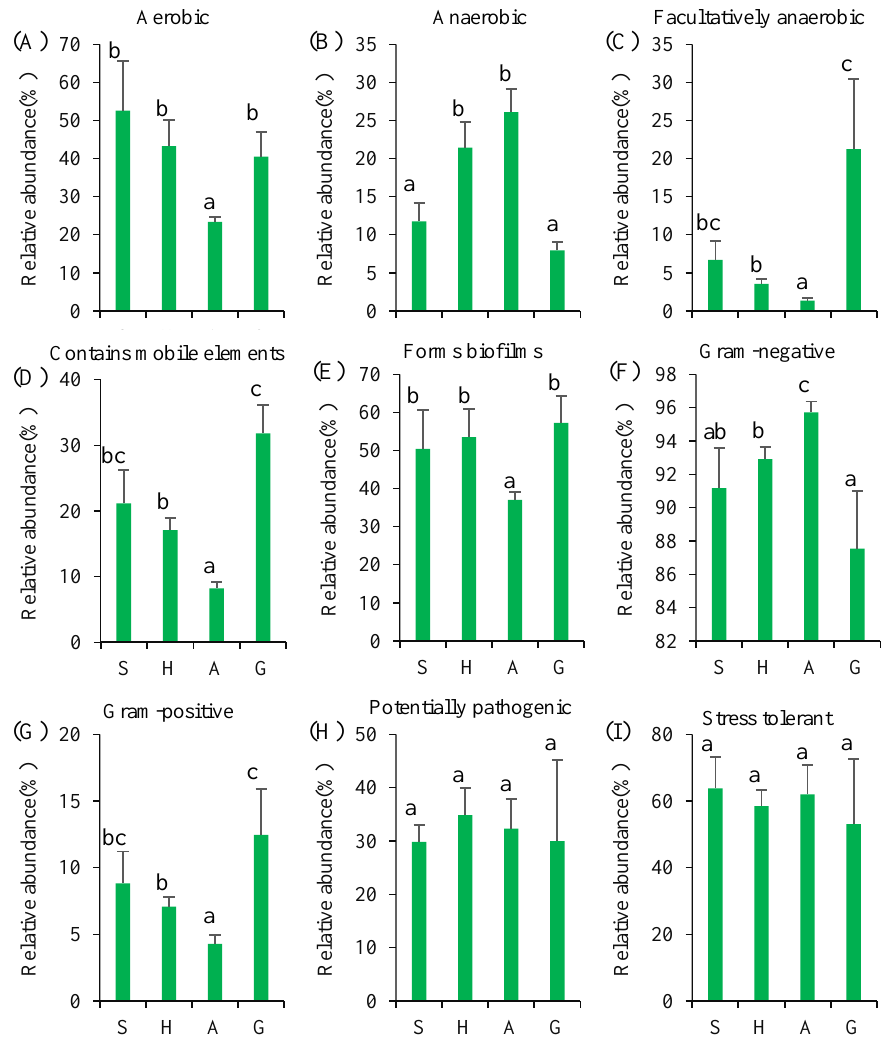
Figure 7. BugBase functional prediction of the microbial communities from intestine and sediment samples: aerobic ( A ); anaerobic ( B ); facultatively anaerobic ( C ); contains mobile elements ( D ); forms biofilms ( E ); Gram-negative ( F ); Gram-positive ( G ); potentially pathogenic ( H ); stress-tolerant ( I ). Different lowercase letters represent significant differences among the treatments ( p < 0.05, Wilcoxon test). S — surface sediment; H — sediment in the hole; A — ambient sediment; G — gut of S. nudus .